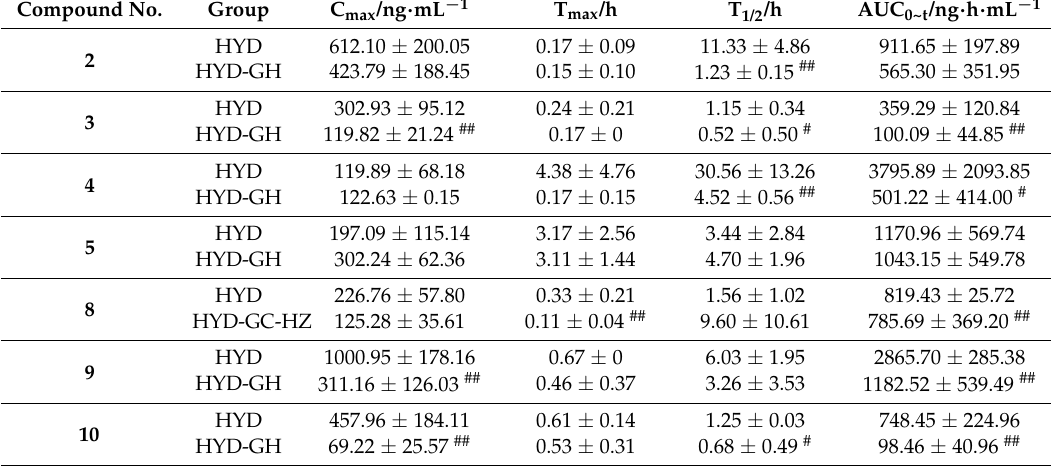
Table 9. Comparison of the Pharmacokinetic Profile of the GC and HYD-HZ Groups. Compound